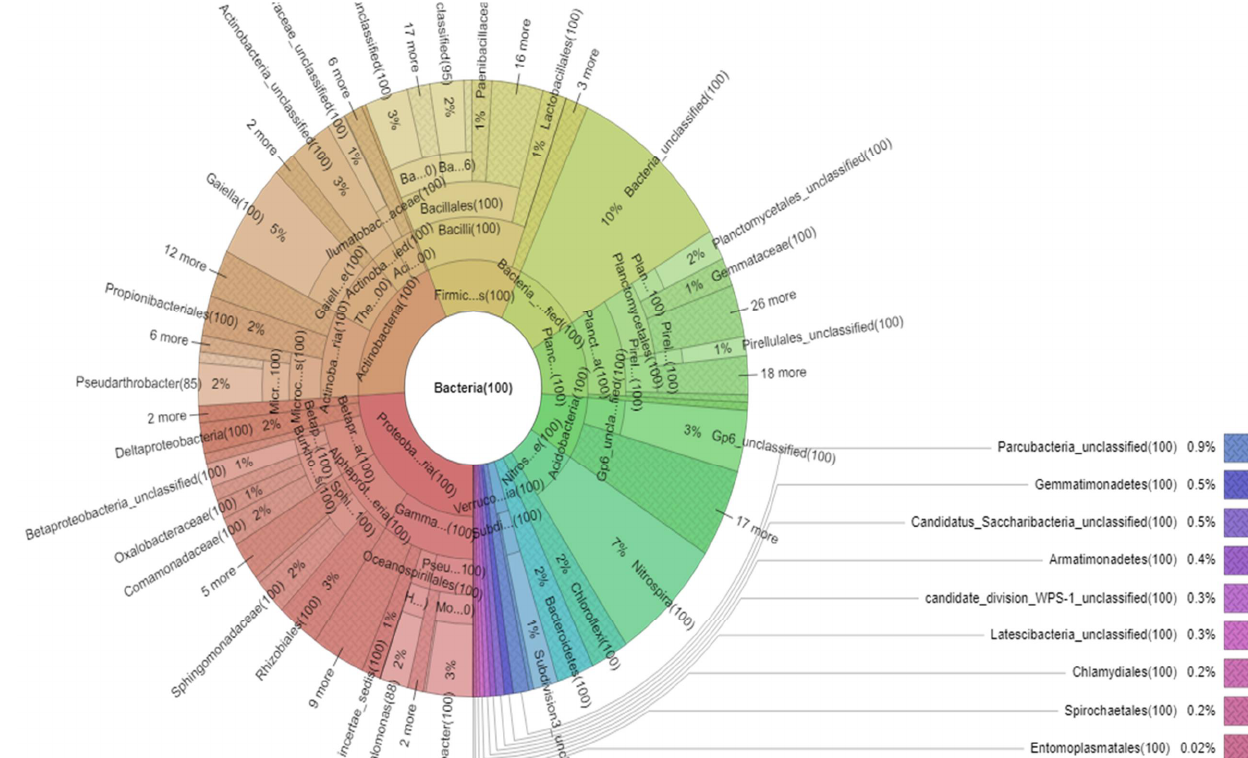
Figure 2. Average of bacteria composition of cave stalactite core sample at phyla and family levels from a total of 352,637 reads.